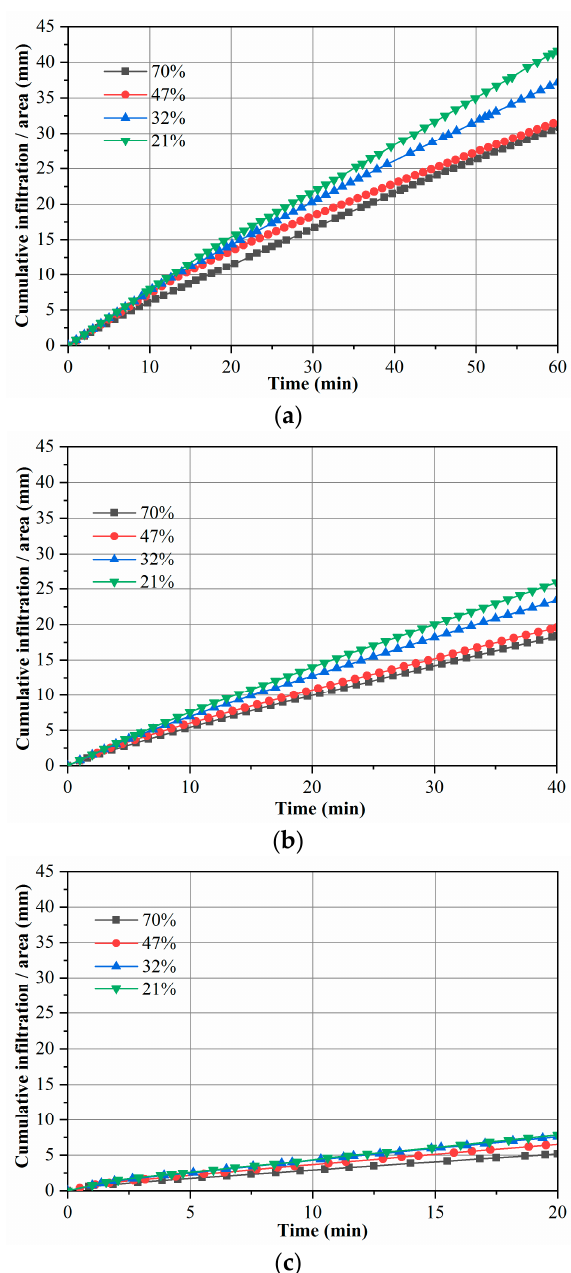
Figure 8. Cumulative infiltration per unit area as a function of time of each slope under different rainfall events: ( a ) Dry run; ( b ) Moderate run; ( c ) Wet run.